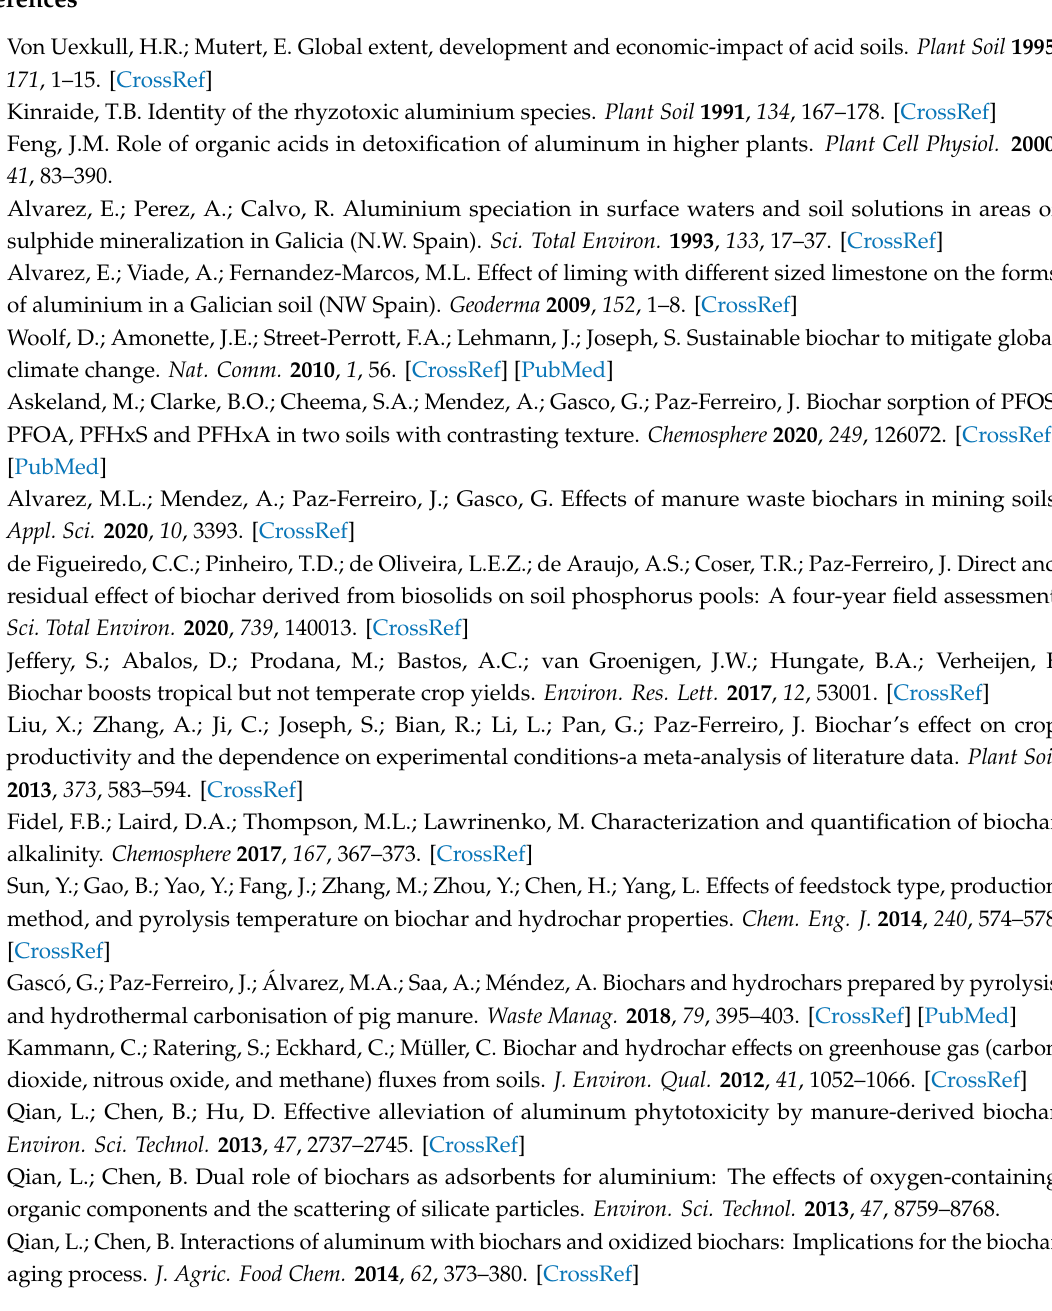
Table S1: Main properties of pig manure, biochars and